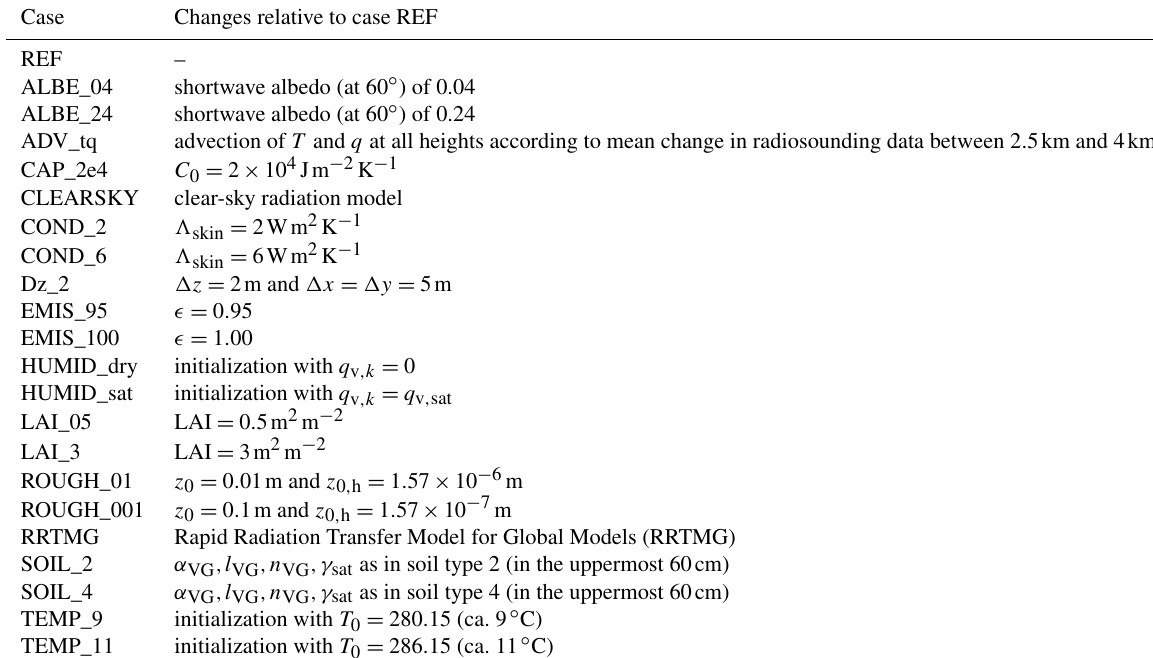
Table 5. Overview of the case study and changes relative to case